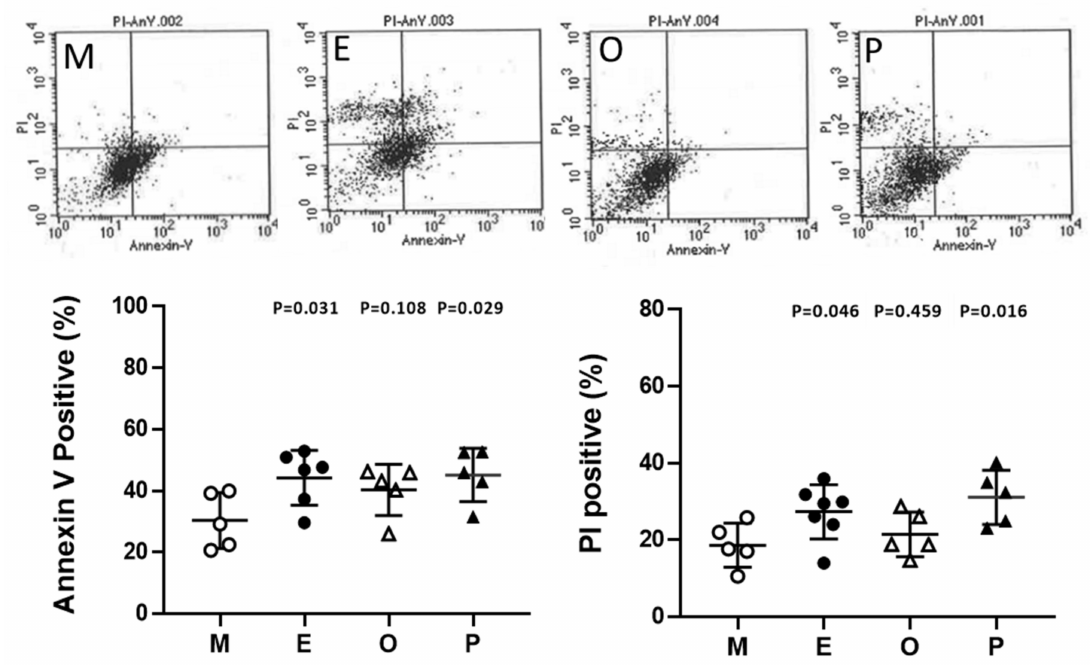
Figure 10. Alteration of granulosa cell apoptosis in various groups. Apoptosis was measured by staining the cell membrane with annexin V- fluorescein-5-isothiocyanate FITC, staining the nucleus with propidium iodide (PI), and measuring the proportion of Annexin V-positive or PI-positive cells by flow cytometry. The top panel shows a scatter plot of each group [male factor ( M ), endometriosis ( E ), other female factors ( O ), and polycystic ovary syndrome ( P )] in a flow cytometer. The bottom panel shows quantitative flow cytometry data. The p -value for each group versus the male factor group was determined by an unpaired t